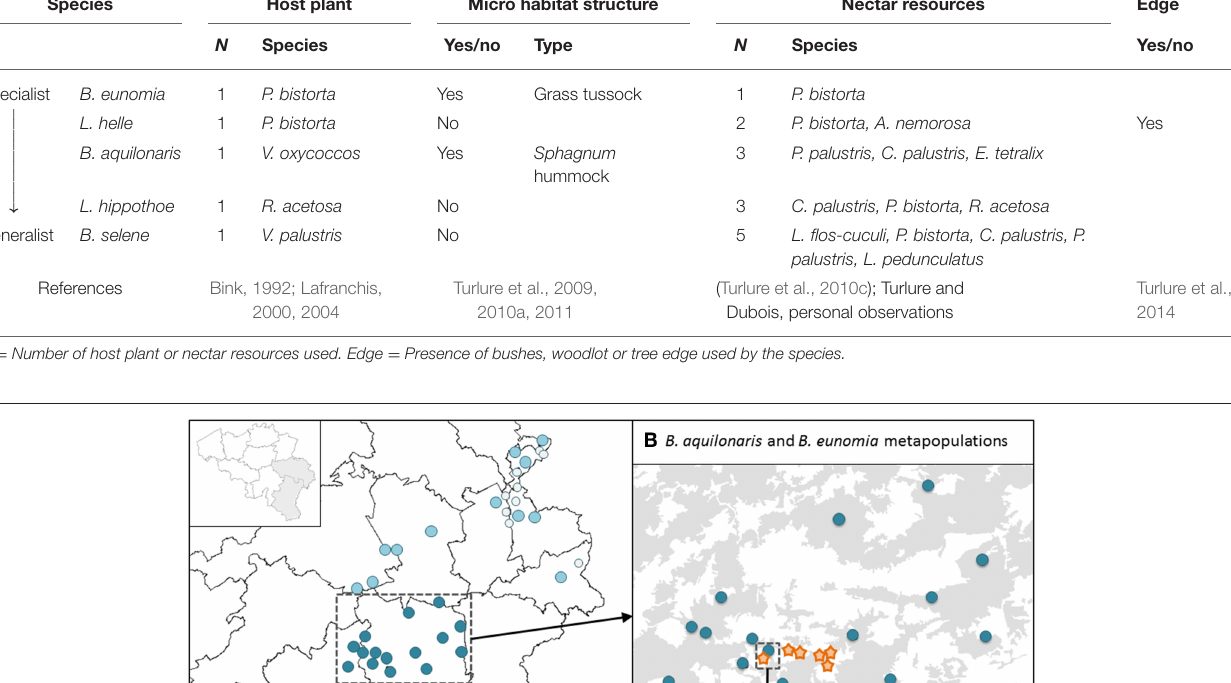
TABLE 1 | List of the resources used by the five study species along the specialist-generalist gradient. Species Host plant Micro habitat structure Nectar resources Edge Species